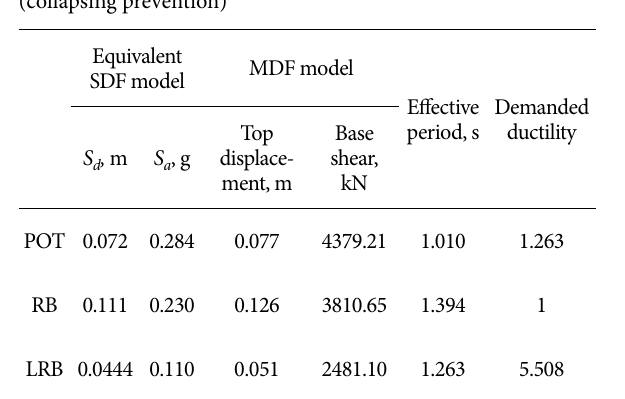
Fig. 10. POT (a), RB (b) and LRB (c) of result of non-linear time-history analysis for each